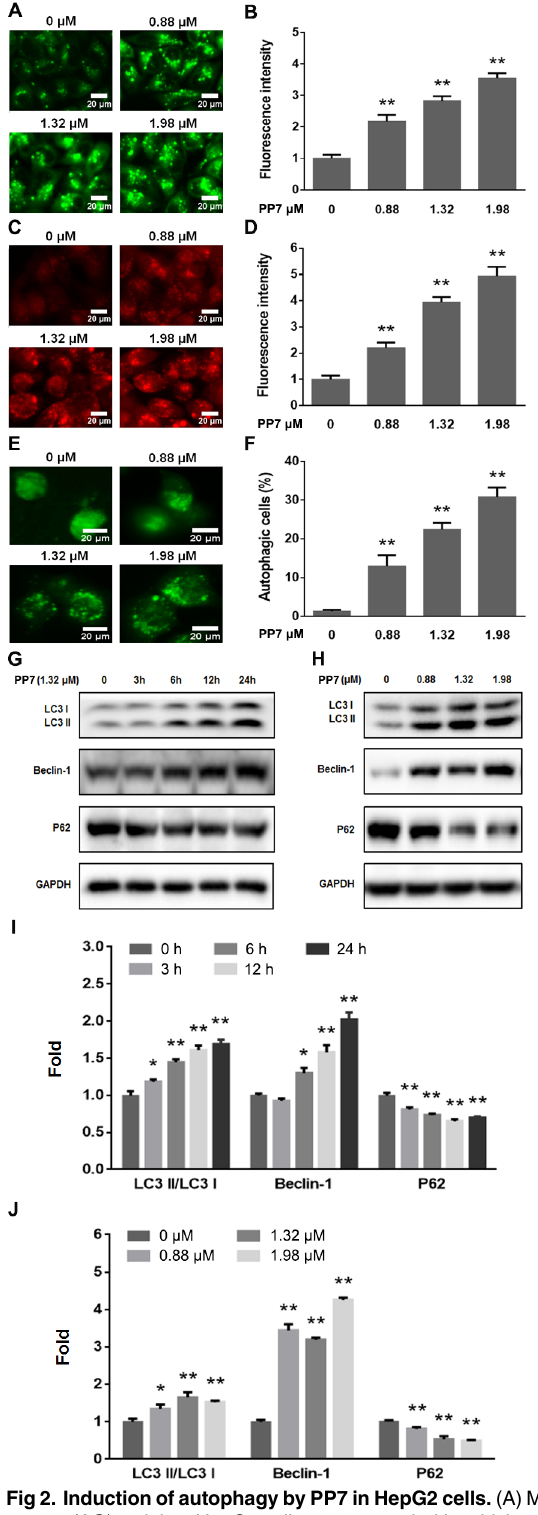
Fig 2. Induction of autophagy by PP7 in HepG2 cells. (A) Monodansylcadaverine (MDC) and (C) Acridine orange (AO) staining. HepG2 cells were treated with vehicle or PP7 for 24 h, stained with MDC and AO, and observed under InCell 2000 confocal microscope (20X objective). The mean fluorescence intensities of MDC (B) and AO (D) in the cells were calculated. (E) GFP-LC3-transfected HepG2 cells were incubated with or